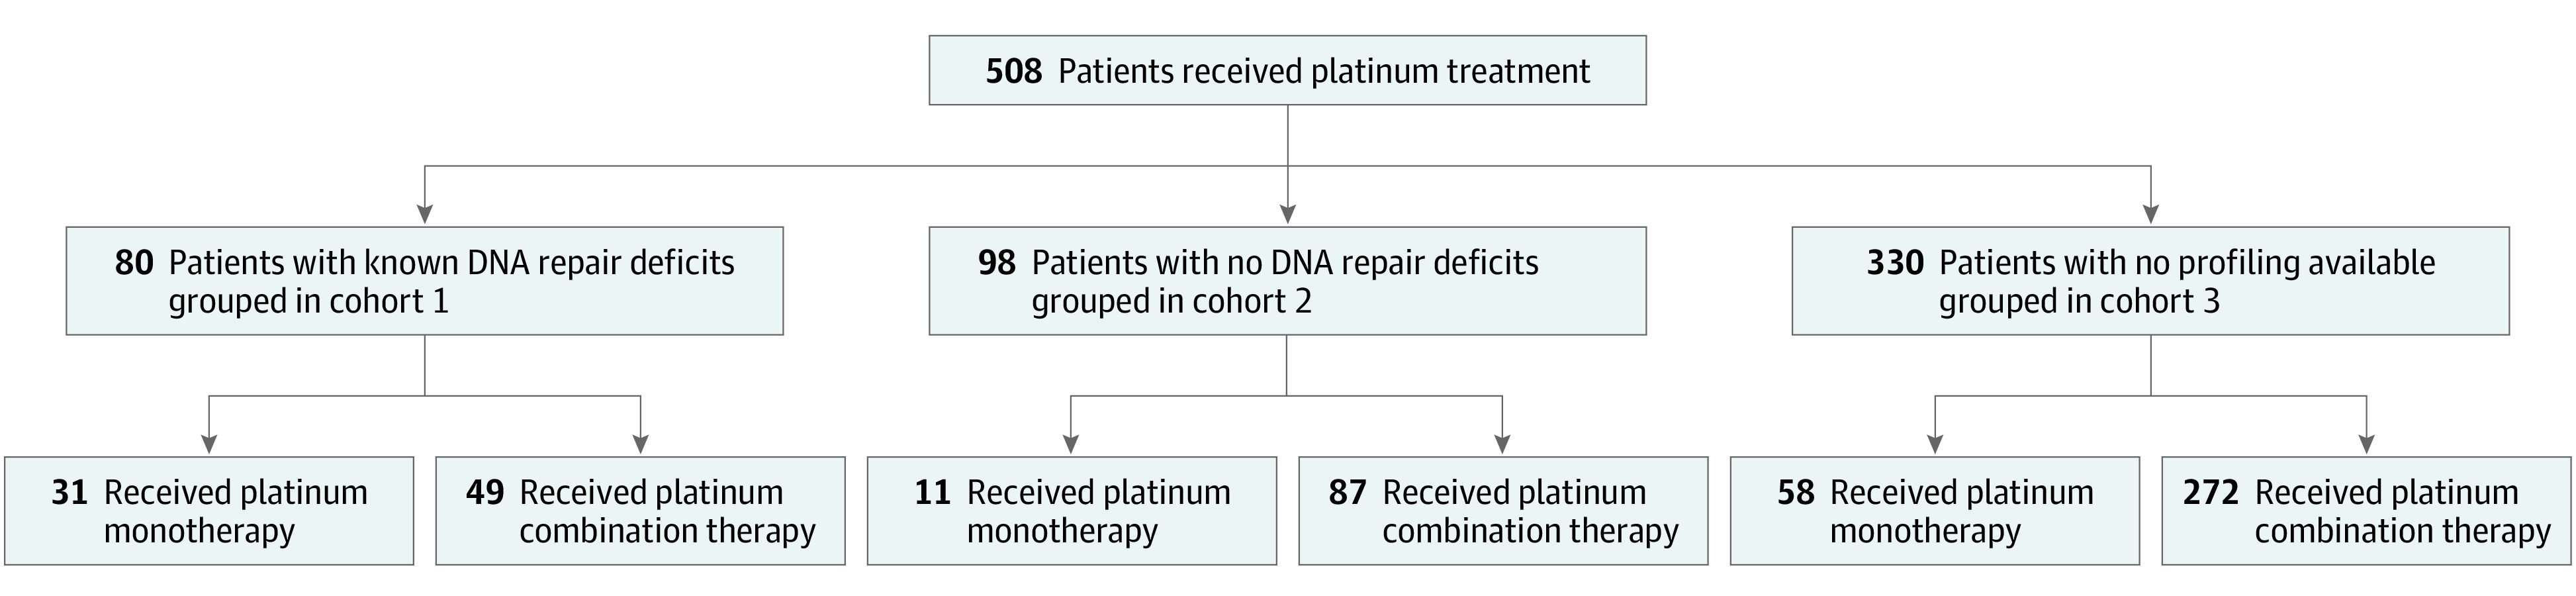
Study Flow Diagram